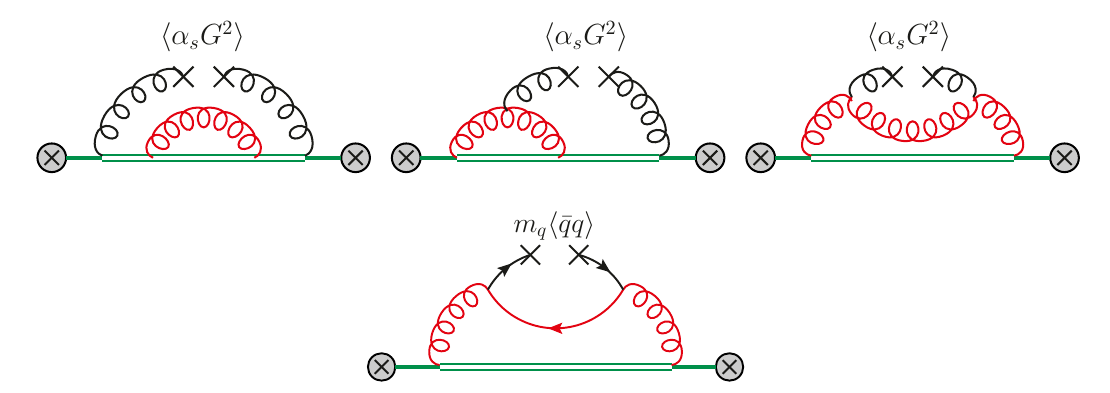
Figure 3 . Corrections to the dimension four condensate contribution to the Green function involv- ing ultrasoft loops. Lines that carry ultrasoft momentum are drawn in